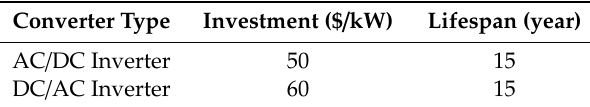
Table 3. Investment Costs of Converters.